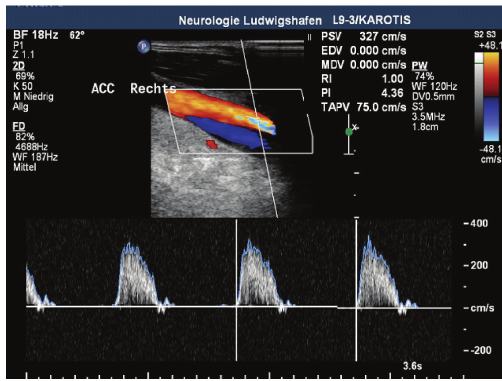
Figure 2: High-grade stenosis of the right common carotid artery (CCA).